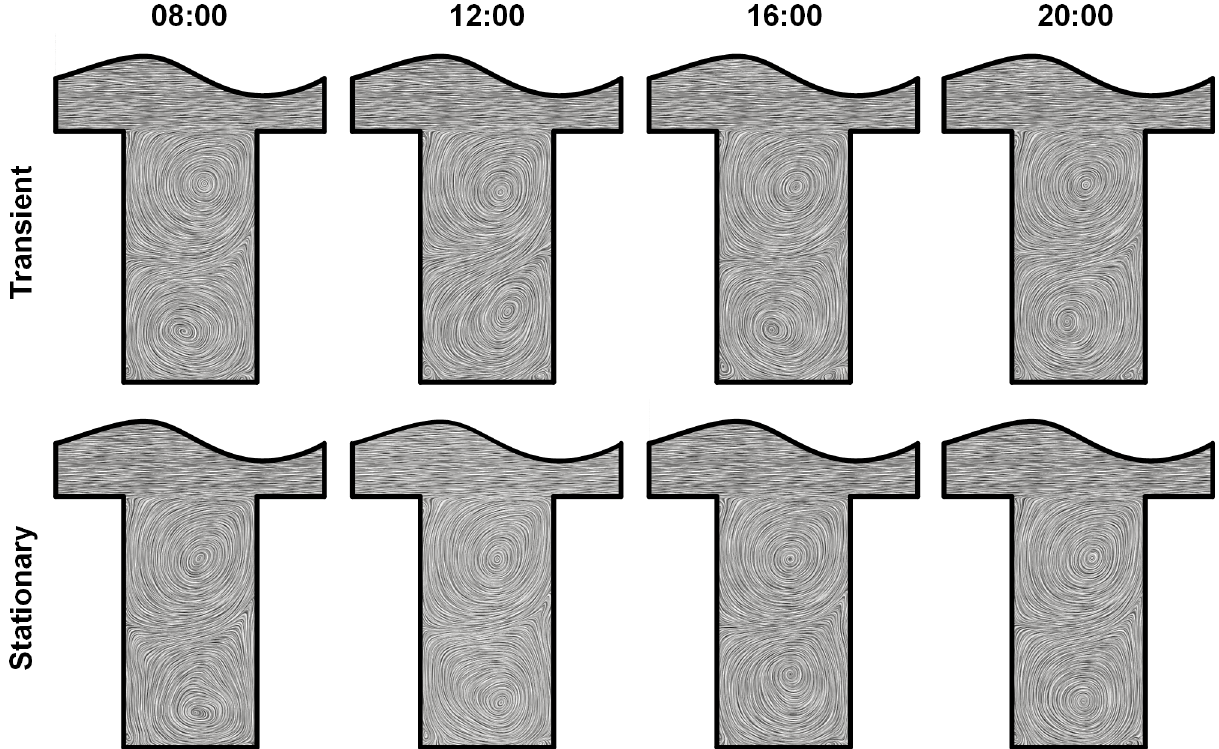
Figure 7. Comparison of LIC representation of hourly mean velocity vector along the x − z plane for transient (top) and stationary (bottom) model runs at various points of time in